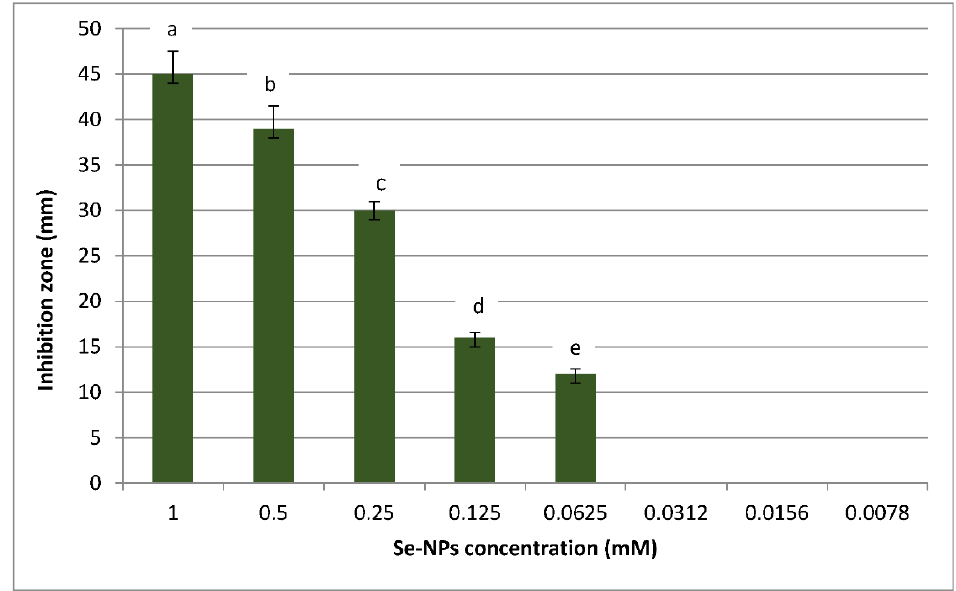
Figure 2. Antifungal activity of different concentrations of Se-NPs against R. solani. Data are expressed as means ± standard deviations of triplicate assays. The different alphabetic superscripts in the same column are significantly different ( p < 0.05) based on Tukey’s multiple comparison test.